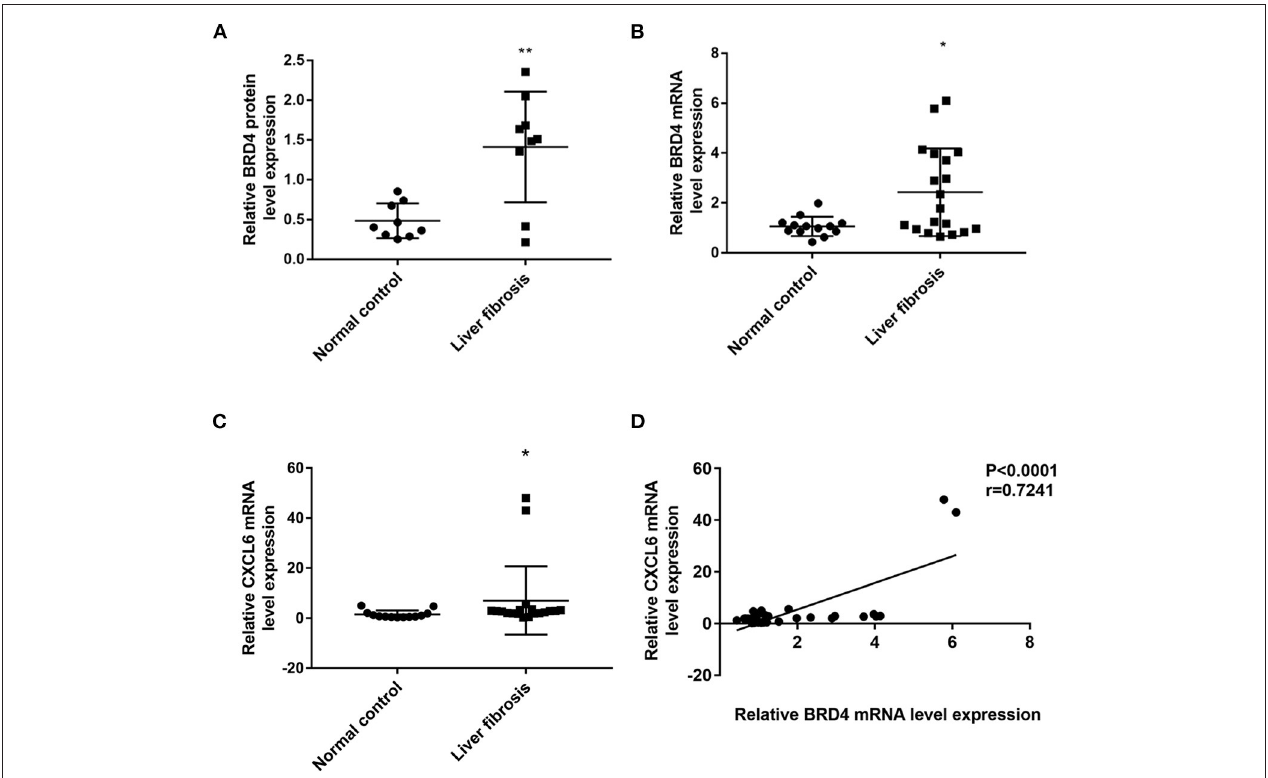
FIGURE 1 | BRD4 and CXCL6 expression in liver tissues of control and fibrosis group. The hepatic tissues were obtained as described in Materials and Methods. (A) BRD4 protein expression in patients with liver fibrosis ( n = 9) and normal controls ( n = 9). Data were expressed as mean ± SEM, Differences between groups were evaluated using two independent samples t -test. (B) mRNA expression level of BRD4 in liver tissues from patients with liver fibrosis ( n = 19) and normal controls ( n = 13). Data were expressed as median M (P25, P75), Differences between groups were evaluated using Mann-Whitney U rank-sum test. (C) CXCL6 mRNA expression in liver fibrosis group ( n = 19) and control group ( n = 13). Data were expressed as median M (P25, P75). Differences between groups were assessed using Mann-Whitney U rank-sum test. (D) Spearman correlation analysis of correlation between CXCL6 mRNA and BRD4 mRNA expression. ** P < 0.01, * P < 0.05